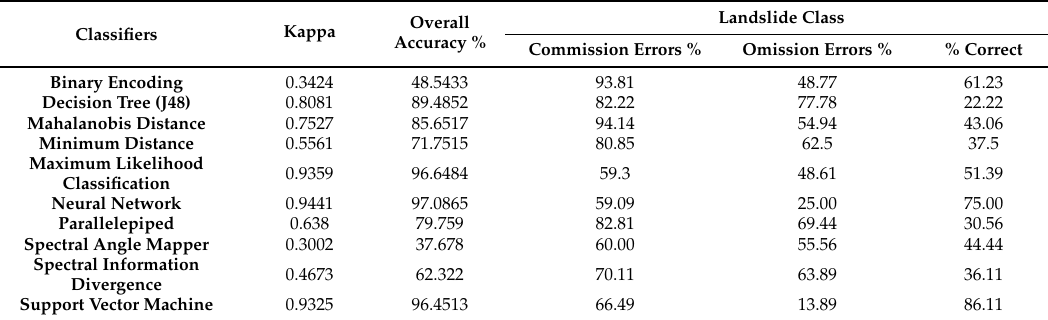
Table 2. Accuracy evaluation for each of the 10 classifiers.